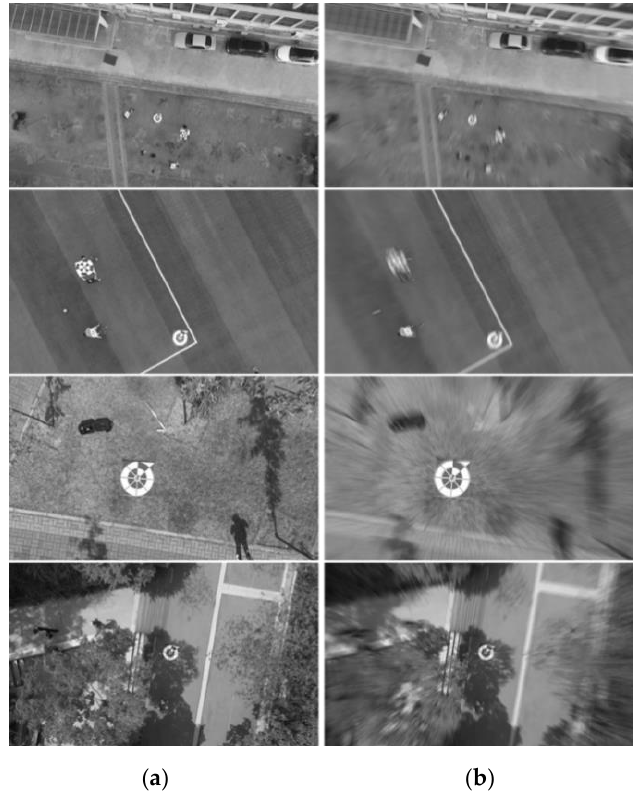
Figure 6. Examples of RMBD-DB1. ( a ) Ground truth (original images), and ( b ) motion-blurred images. Table 4. Descriptions of SMBD-DB1.